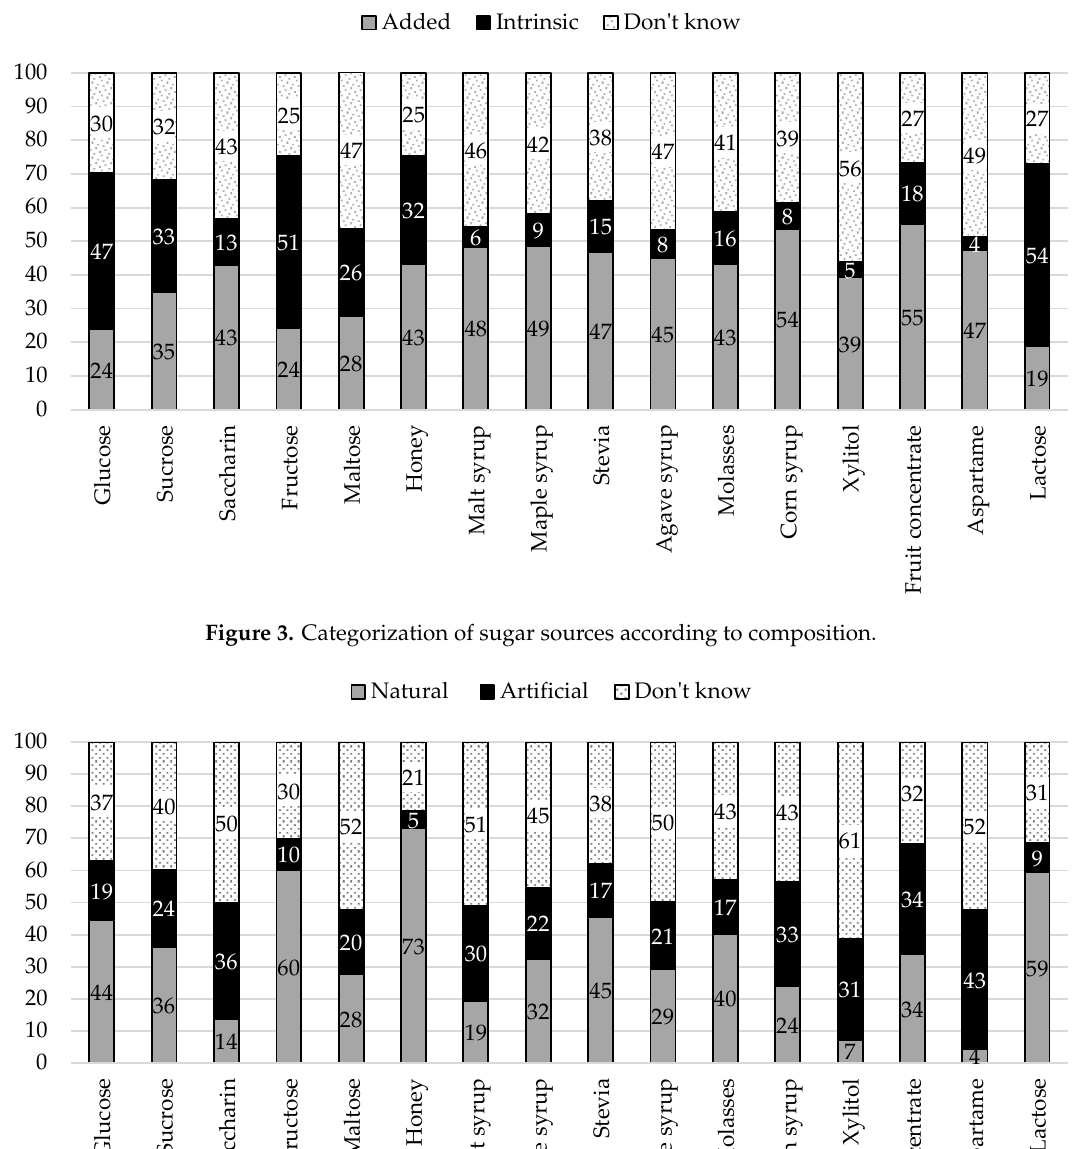
Figure 4. Categorization of sugar sources according to origin.